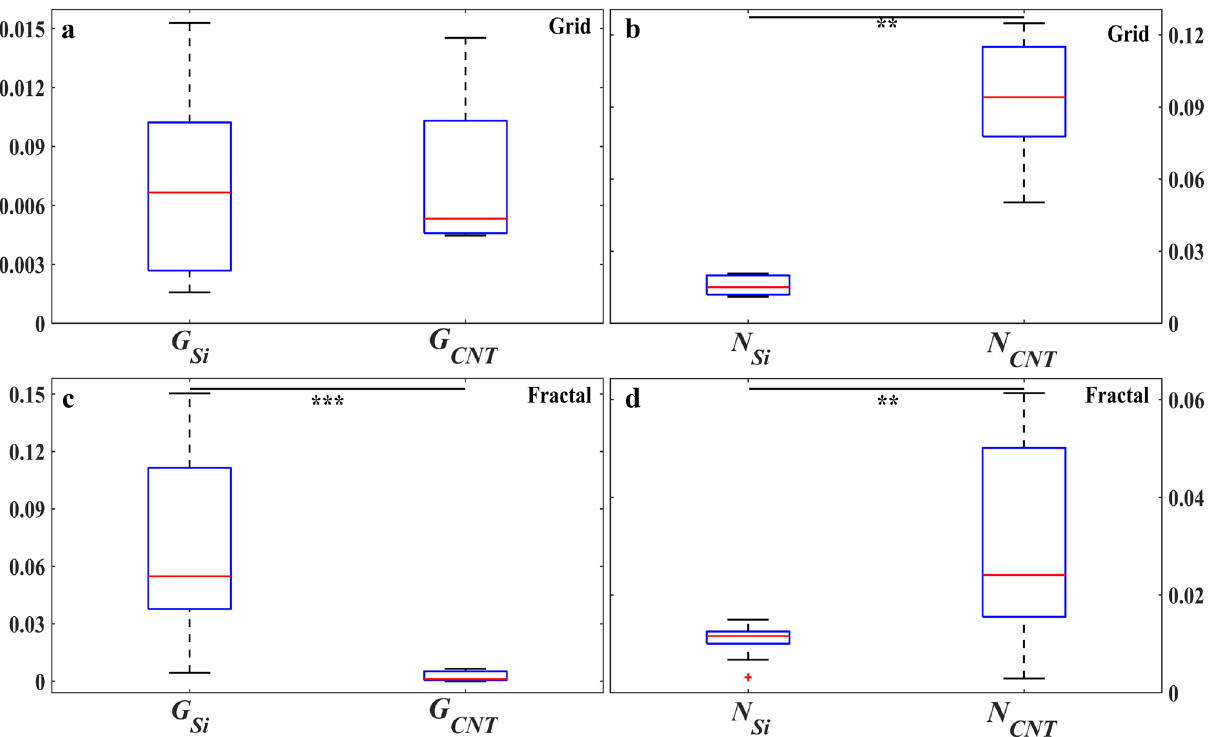
Figure 3. Comparison of glial and neuronal behavior on the SiO 2 and VACNT surfaces for the grid and fractal electrodes at 17 DIV. Statistical analysis showing boxplots of G Si (left) compared with G CNT (right) for the ( a ) grids and ( c ) fractals, as well as N Si (left) compared with N CNT (right) for the ( b ) grids and ( d ) fractals. The y axes of ( a ) and ( c ) display the range of G Si and G CNT values and the y axes of ( b ) and ( d ) display the range of N Si and N CNT values. Stars in panels ( b – d ) indicate the degrees of significance: *** and **denote p ≤ 0.001 and p ≤ 0.01, respectively. The red plus in panel ( d ) is an outlier. Note that G Si and G CNT are unitless and N Si and N CNT have units of µm −1 (see “Materials and methods”